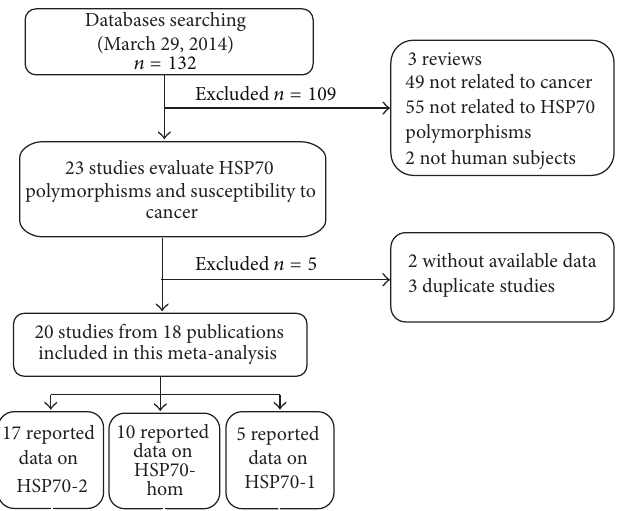
Figure 1: Flow chart showing study selection